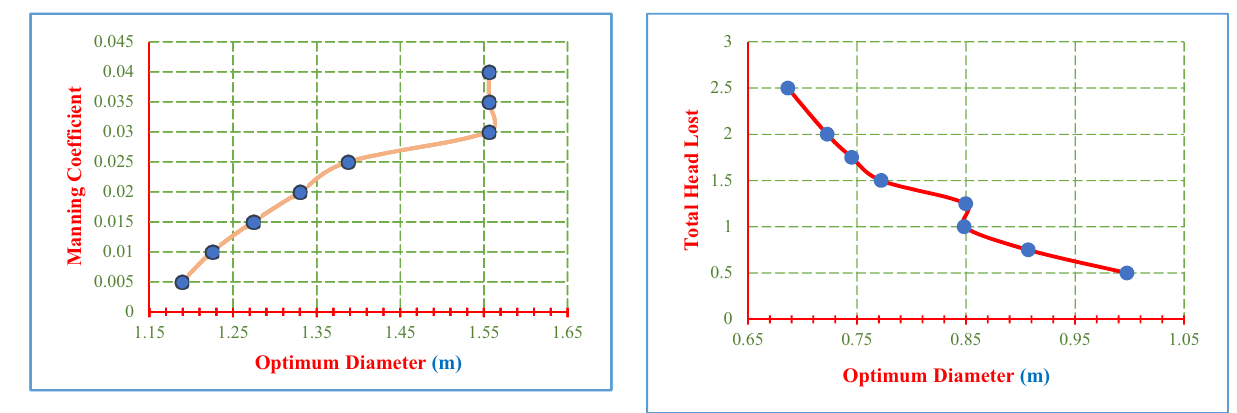
Figure 11: Total head lost vs optimum diameter.